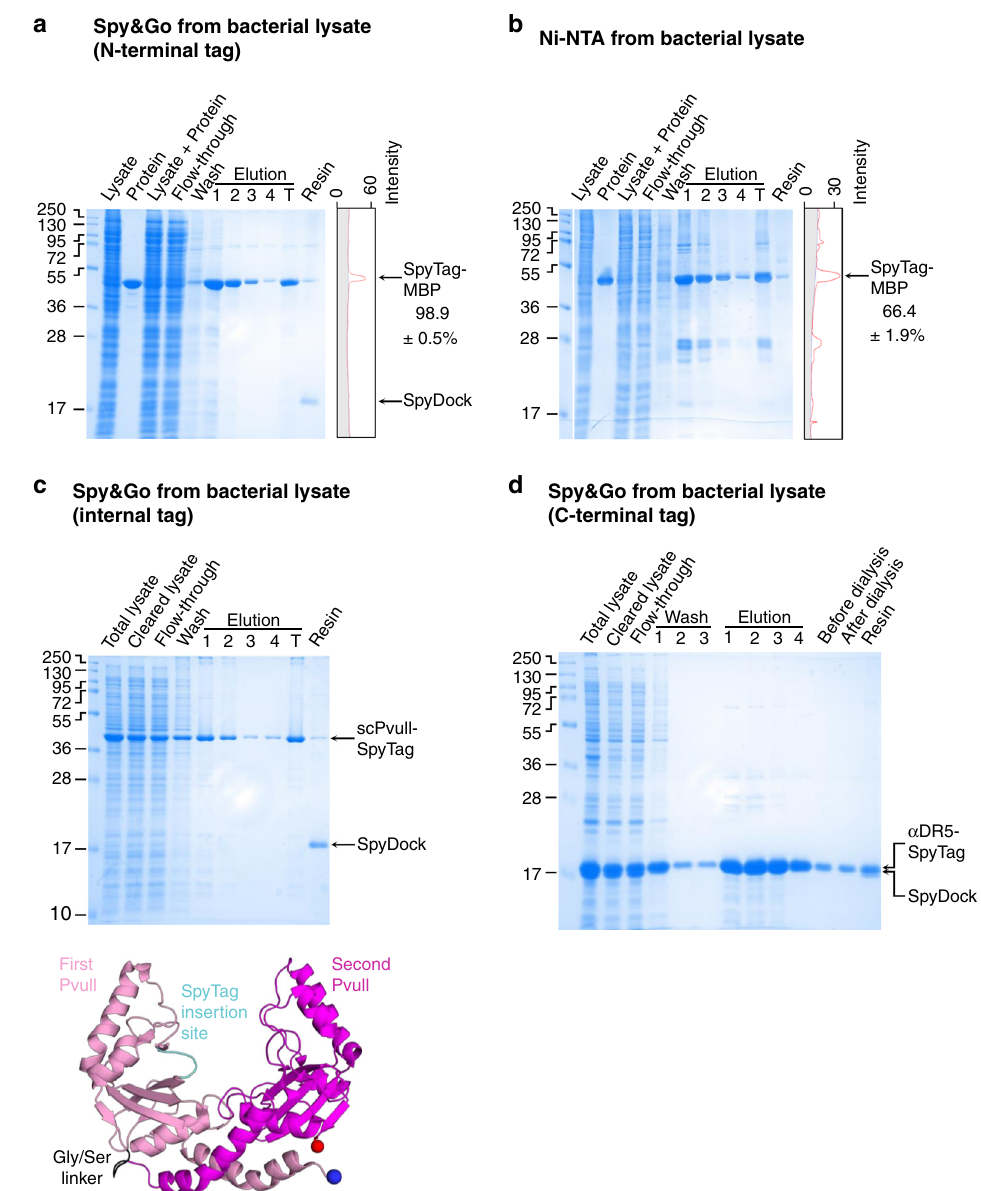
Fig. 4 Spy&Go from bacterial expression. a SpyTag-MBP was puri fi ed from E. coli clari fi ed lysate by Spy&Go. Protein: input SpyTag-MBP protein. T: total pooled elutions. Purity of T was determined by densitometry (right); gray represents background lane intensity (mean ± 1 s.d., n = 3). b Ni-NTA puri fi cation of SpyTag-MBP from the same lysate via its His-tag. c Spy&Go puri fi cation of scPvuII-SpyTag (SpyTag at an internal loop, shown schematically) from bacterial lysate. d Spy&Go puri fi cation of the nanobody α DR5-SpyTag (C-terminal fusion) from bacterial lysate. All fractions were analyzed by SDS-PAGE with Coomassie